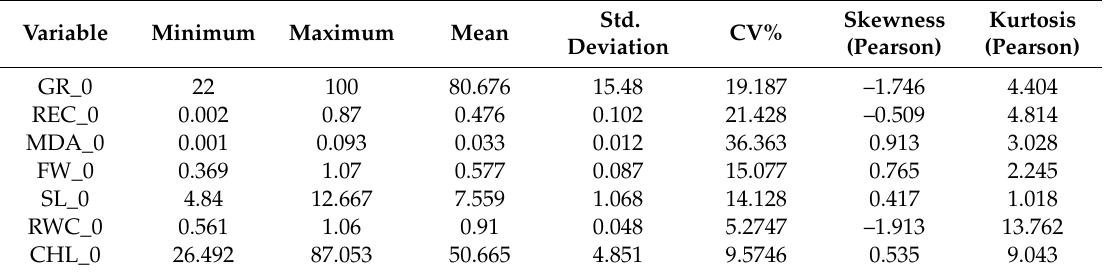
Table1phenotypictraitsabbreviatedasGR,germination; REC,relativeelectricconductivity; MDA,melondialdehyde; FW, fresh weight; SL, seedling length; RWC, relative water content; CHL, chlorophyll content; 0, (0 mM). Table 2. Descriptive statistics of phenotypes under salt stress.